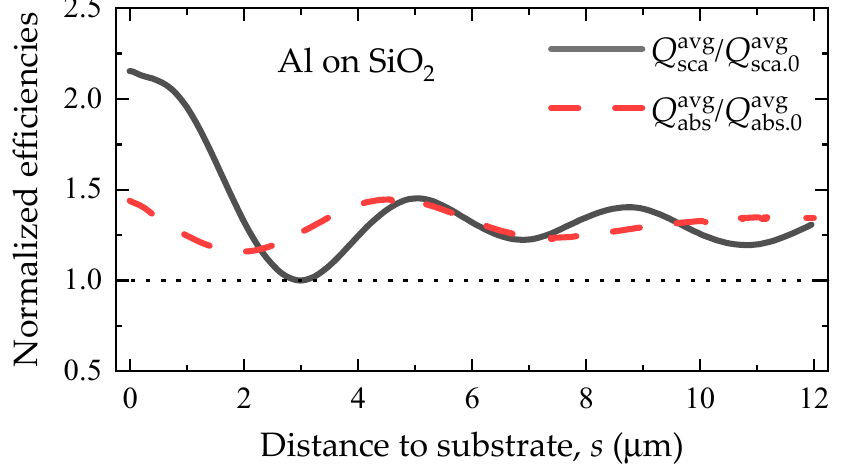
Figure 8. The wavelength-averaged e ffi ciencies of the Al particle on the SiO 2 substrate versus the